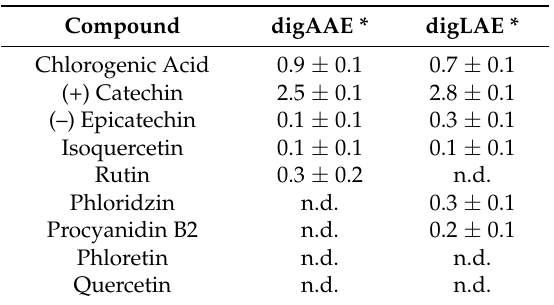
Table 4. Polyphenolic content of in vitro digested AAE and